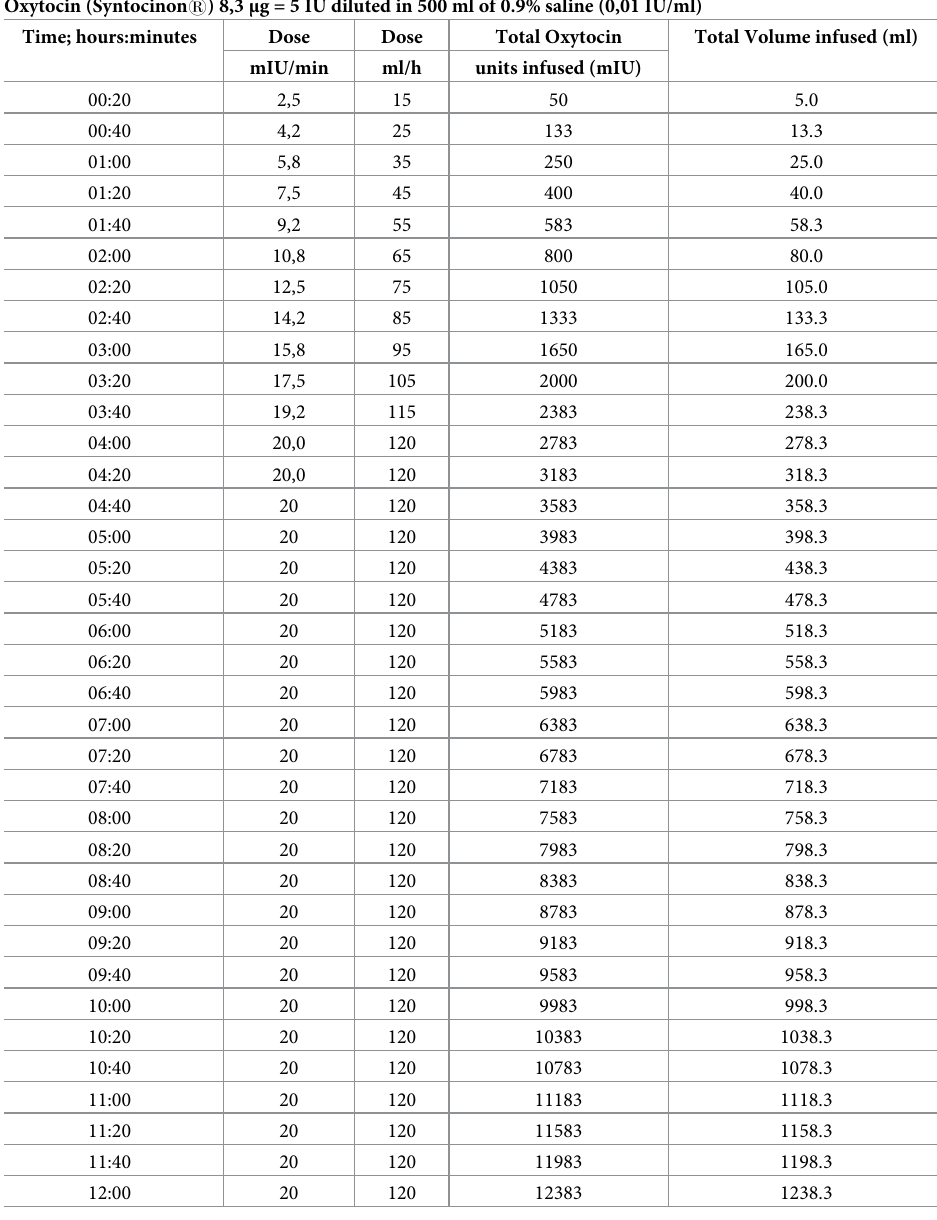
Table 2. The new intravenous high-dose oxytocin infusion protocol. Oxytocin (Syntocinon 1 ) 8,3 μ g = 5 IU diluted in 500 ml of 0.9% saline (0,01